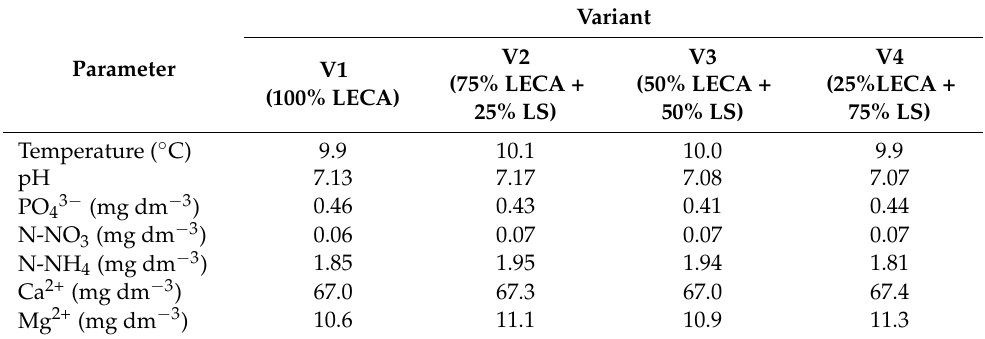
Table 2. Properties of the hypolimnetic water used in the